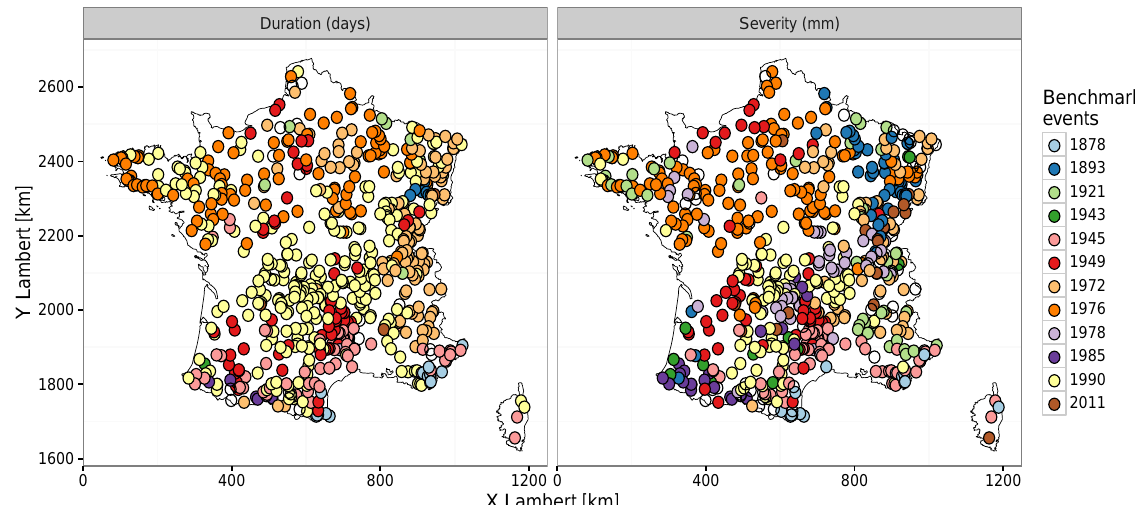
Figure 15. Benchmark events selected from median characteristics over the 1871–2012 period. Filled white circles identify stations which share their most extreme event with less than four other ones. These events are not listed in the